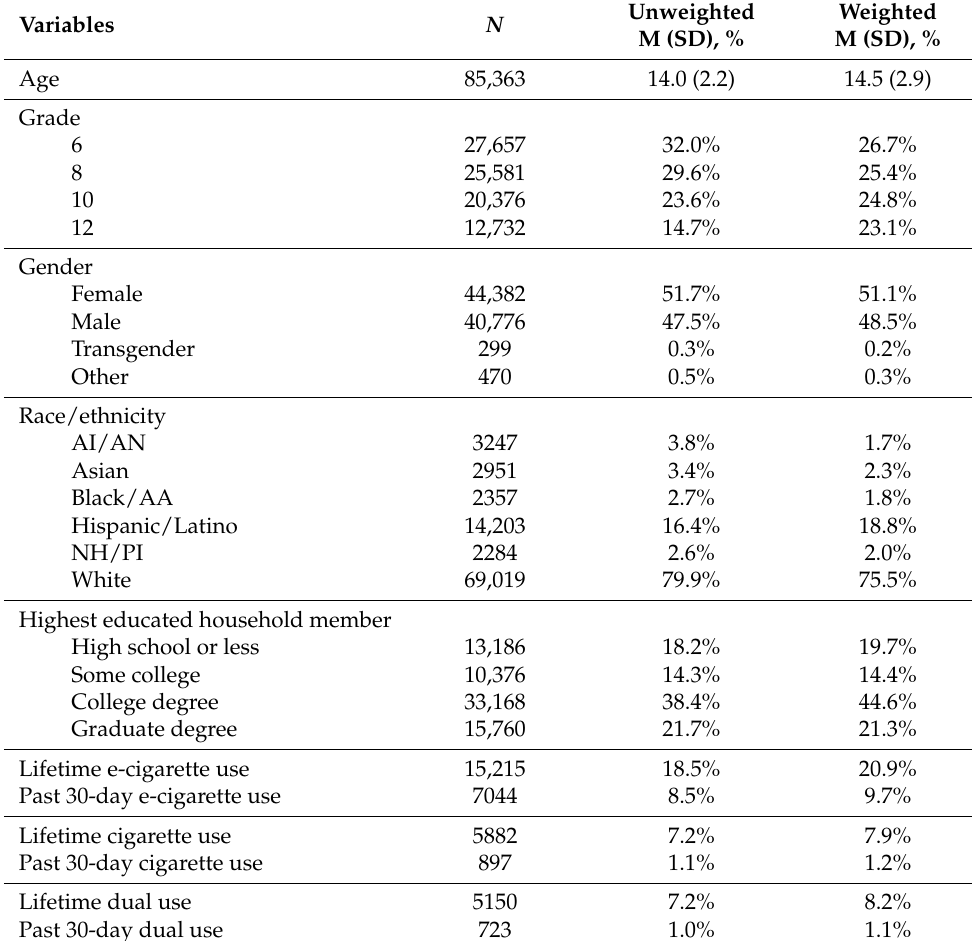
Table 1. Sample characteristics and population estimates.